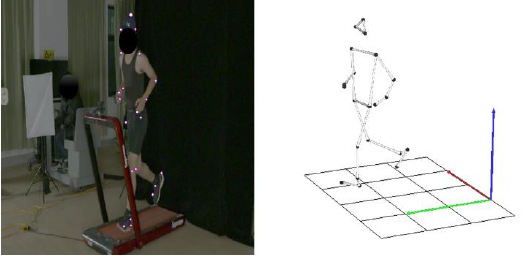
Figure 2. Motion analysis suite processes captured images.